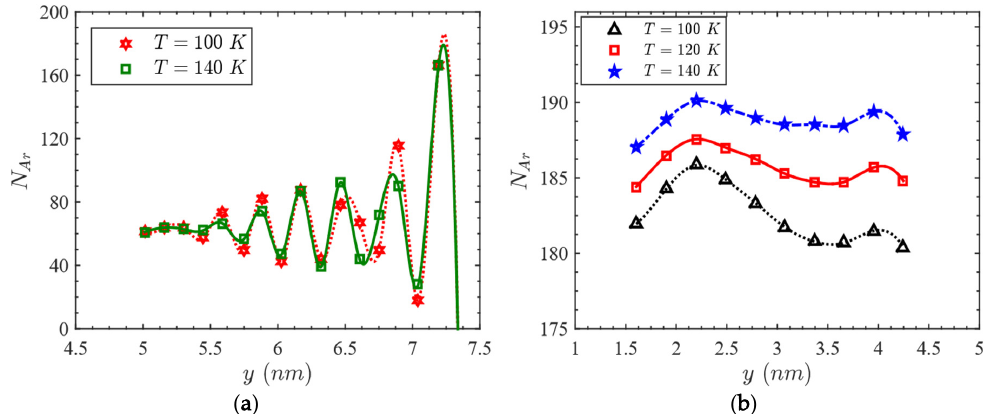
Figure 8. For different system temperatures (a) density profile of the liquid Ar near the Cu wall, (b) Figure 8. For di ff erent system temperatures ( a ) density profile of the liquid Ar near the Cu wall, density profile of the liquid Ar far from the Cu wall. ( b ) density profile of the liquid Ar far from the Cu